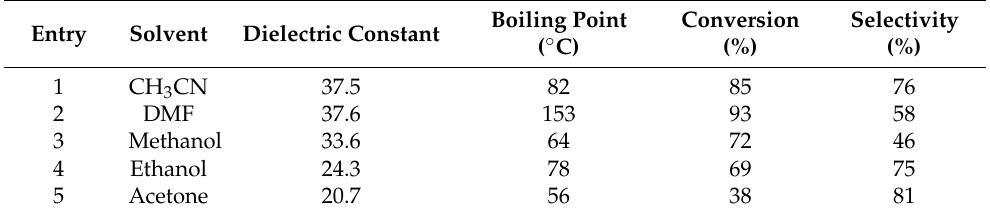
Table 3. Catalytic performance of Cu 2 O@Cu-BDC-NH 2 -8h for selective oxidation of styrene with different solvents a .